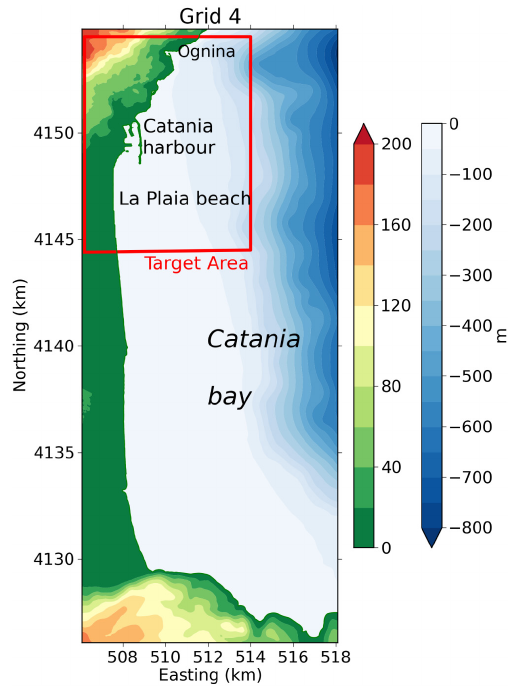
Fig. 5. Topography and bathymetry of grid 4. The red rectangle shows the target area selected to perform the tsunami hazard analy- sis for